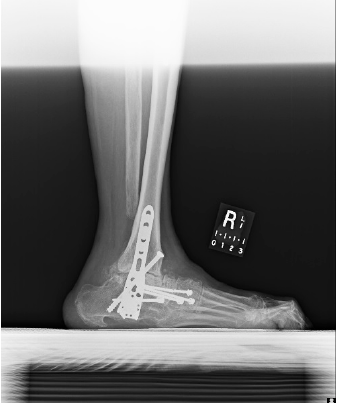
Figure A2. 18 months post-op imaging with evidence of breakage of a distal 3.5 mm talonavicular screw.